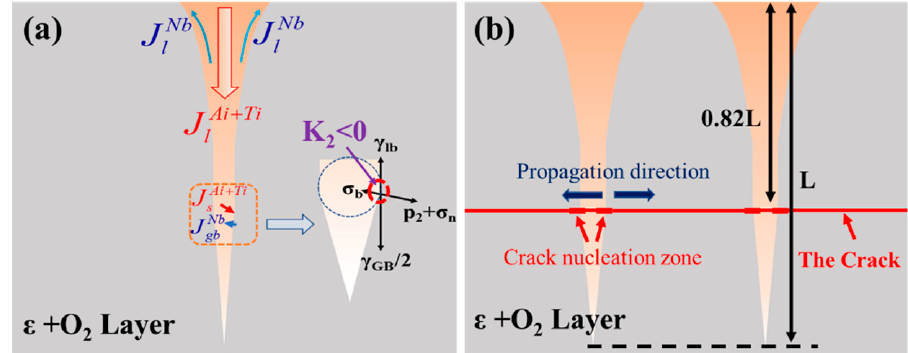
Figure 10. ( a ) Schematic illustration of the related stress interactions coupled with element diffusion, ( b ) Schematic illustration of Crack nucleation and propagation.